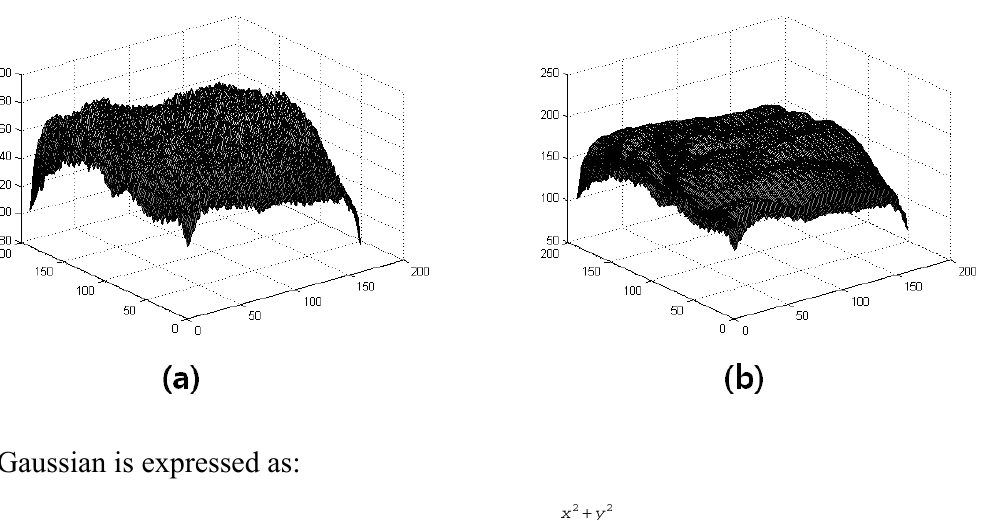
Figure 4. Gaussian filter. ( a ) Vascular image; ( b ) Image after Gaussian